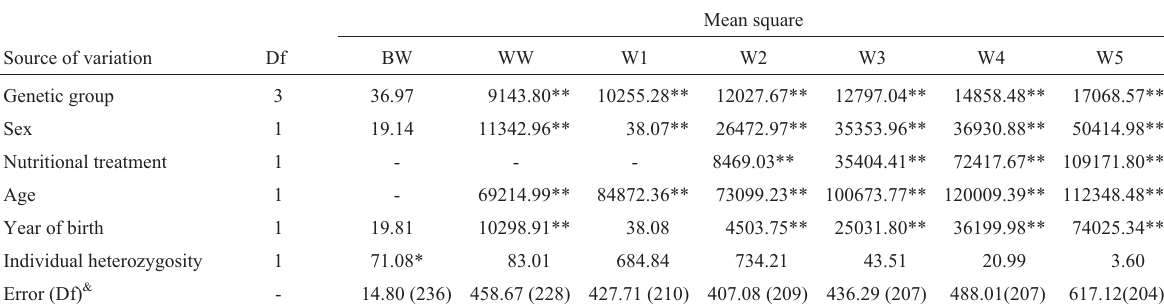
Table 3 - Summary of analysis of variance (ANOVA) for birth weight (BW), weaning weight (WW) and the five subsequent weights (W1, W2, W3, W4 and W5).